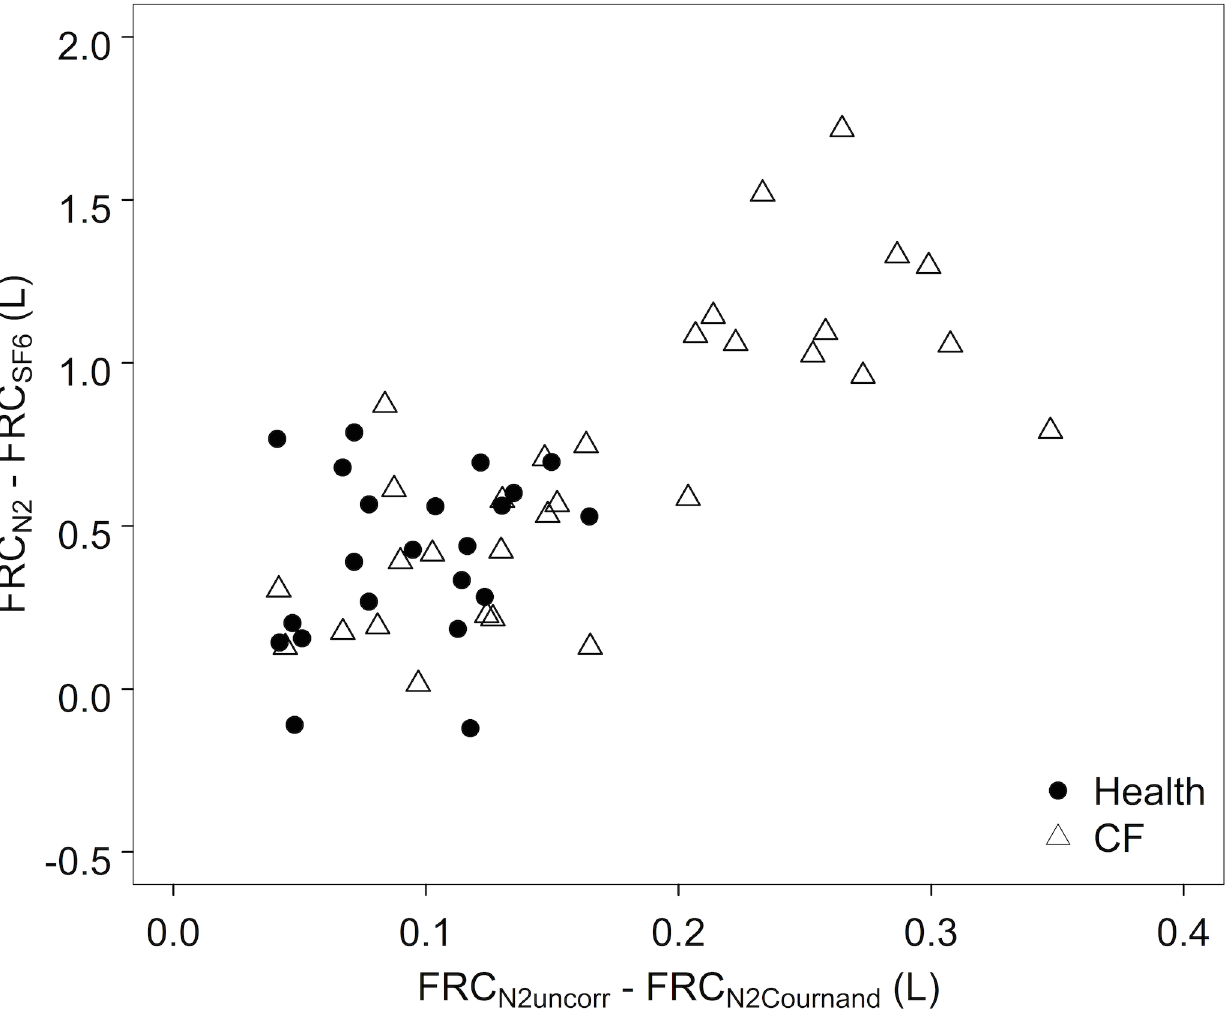
Fig 3. Relationship between the contribution of tissue N 2 to FRC N2 and the difference between FRC as measuredby MBW N2 and MBW SF6 . FRC N2 became disproportionately greater than FRC SF6 as the contribution of tissue N 2 estimated by the within-subject difference FRC N2 —FRC Cournand